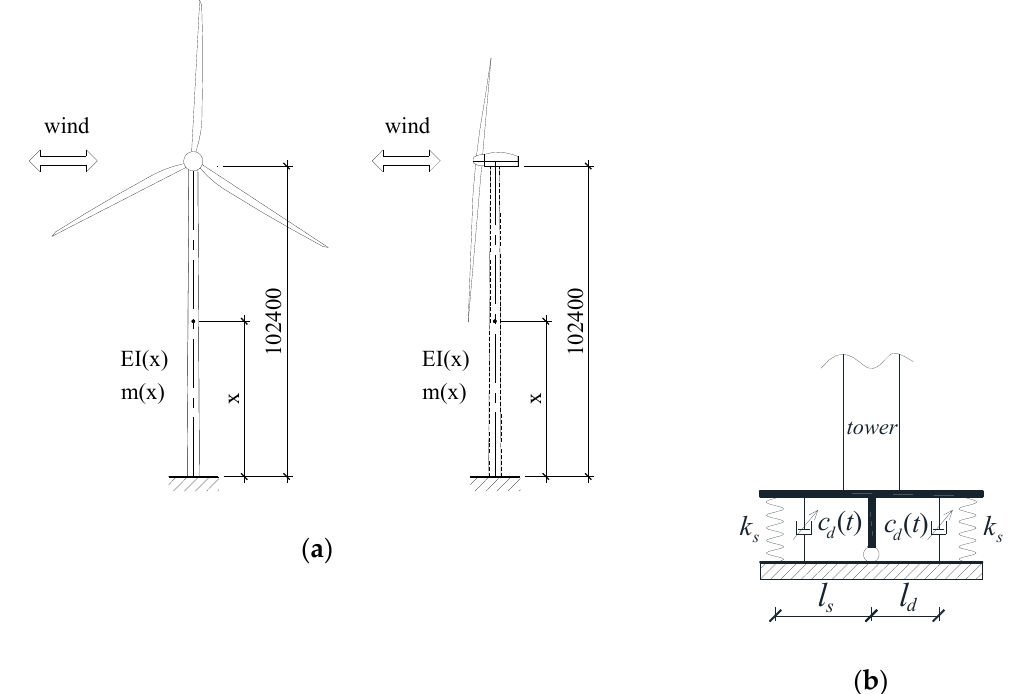
Figure 4. ( a ) “Fixed base” configuration of the case-study wind turbine (dimensions in mm). ( b ) Base restraint for the SA controlled configuration.